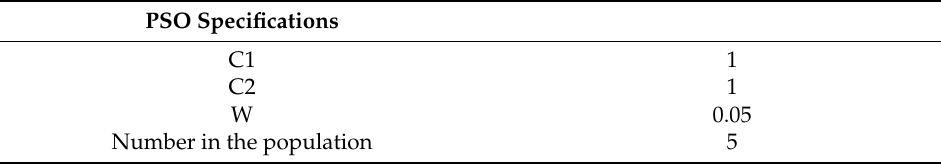
Table 5. The PSO specification for the optimization procedure.